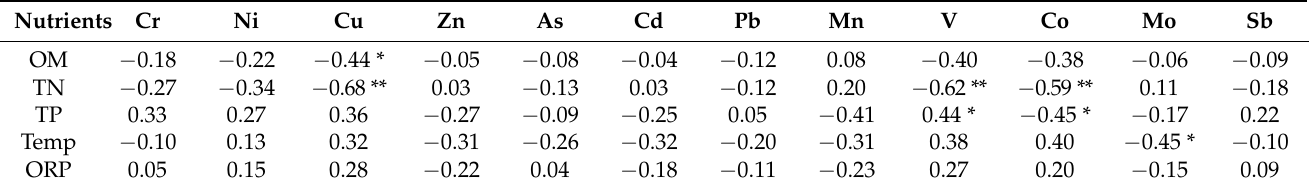
Table 6. Spearman’s correlation coefficients between metals in surface sediments and